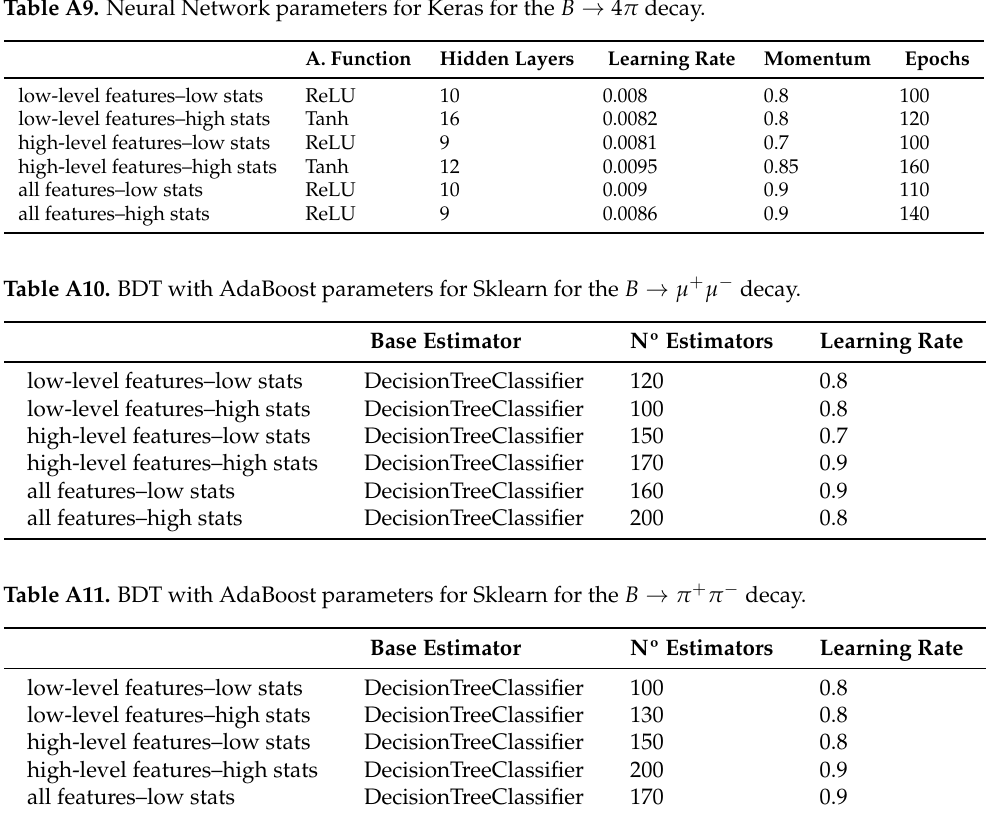
Table A9. Neural Network parameters for Keras for the B